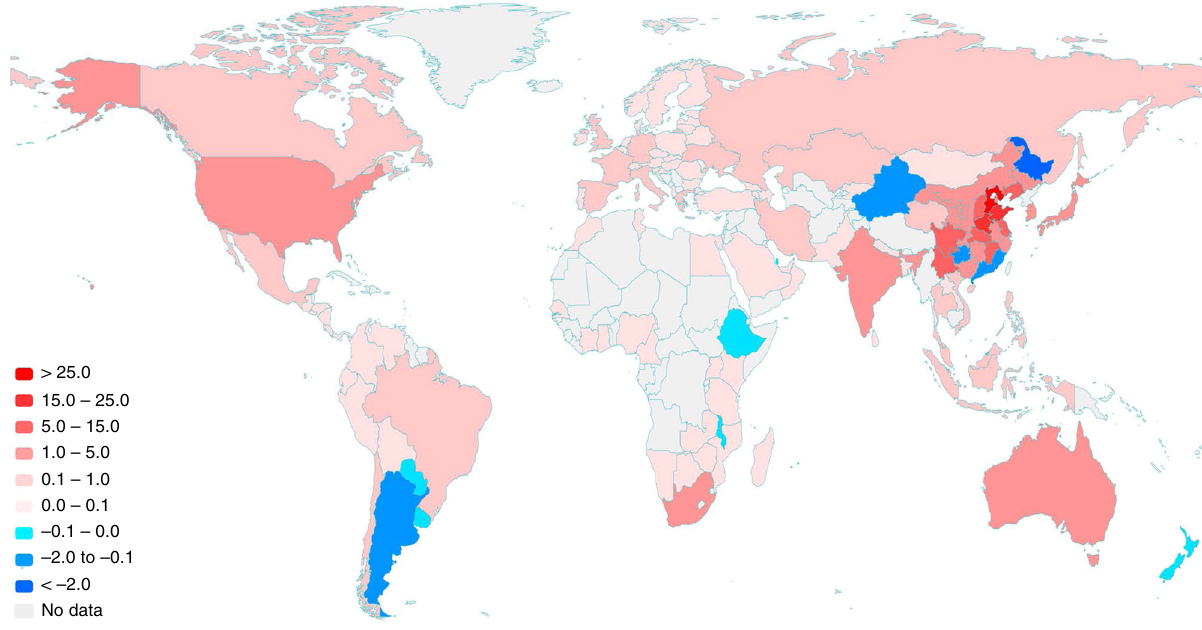
Fig. 2 Changes in CO 2 emissions of nations and Chinese regions caused by saving rate changes in China during 2007 – 2012 (Mt). CO 2 emission changes caused by saving rate increase in China varied across nations and Chinese regions. Saving rate changes in China caused CO 2 emission increase in regions of red colour, while caused CO 2 emission decrease in regions of blue colour. A darker colour indicates a larger CO 2 emission